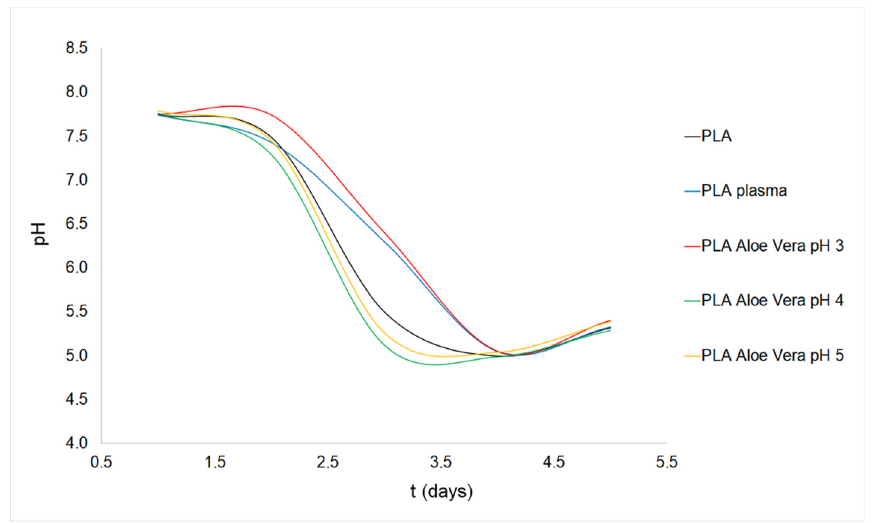
Figure 3. Variation of the pH level of the degradation medium during the enzymatic degradation study of the 3D-printed scaffolds.